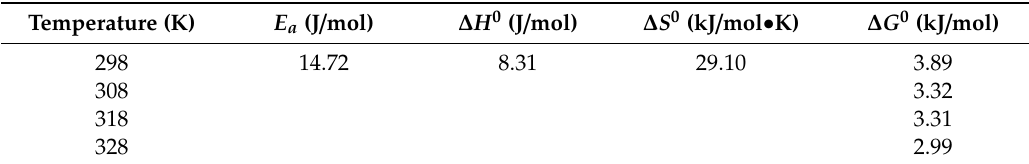
Table 5. Thermodynamic parameters for the removal of As(V) onto